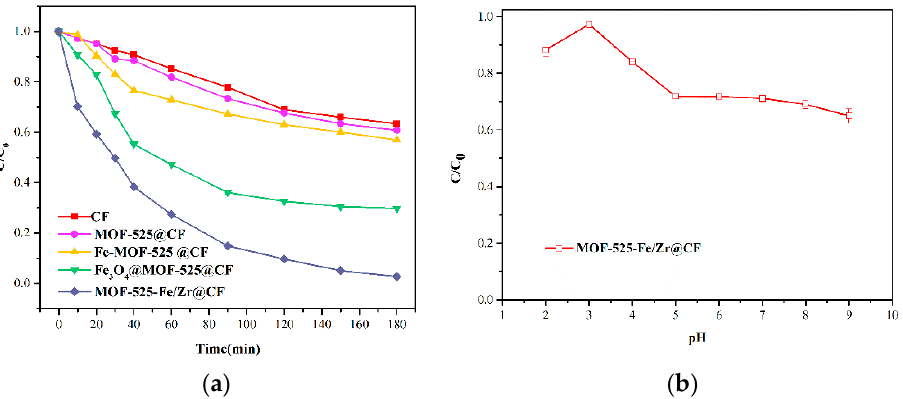
Figure 6. Comparison of SMX degradation efficiency of ( a ) different catalyst-modified cathodes, ( b ) different pH values in the PEF process.